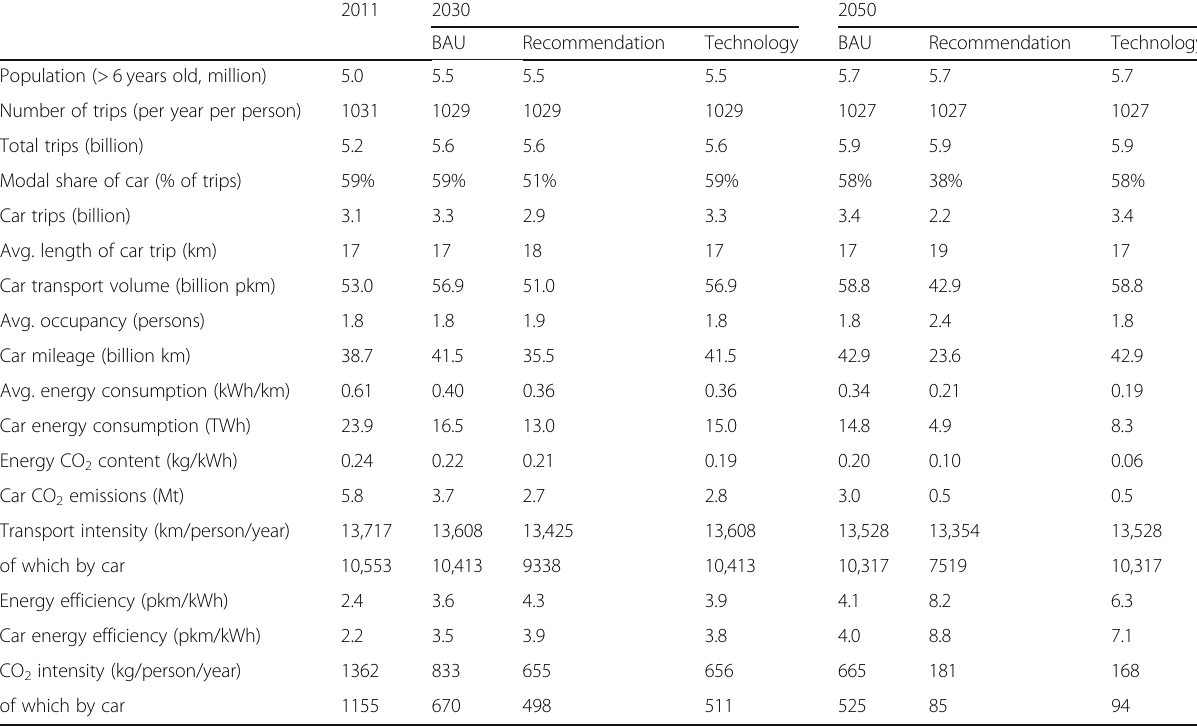
Table 3 Values of framework indicators for passenger cars in three scenarios in 2011, 2030 and